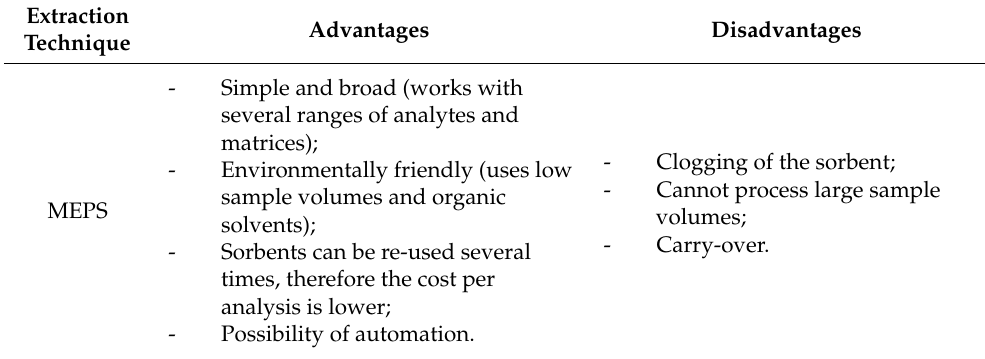
Table 1. Advantages and disadvantages of the MEPS